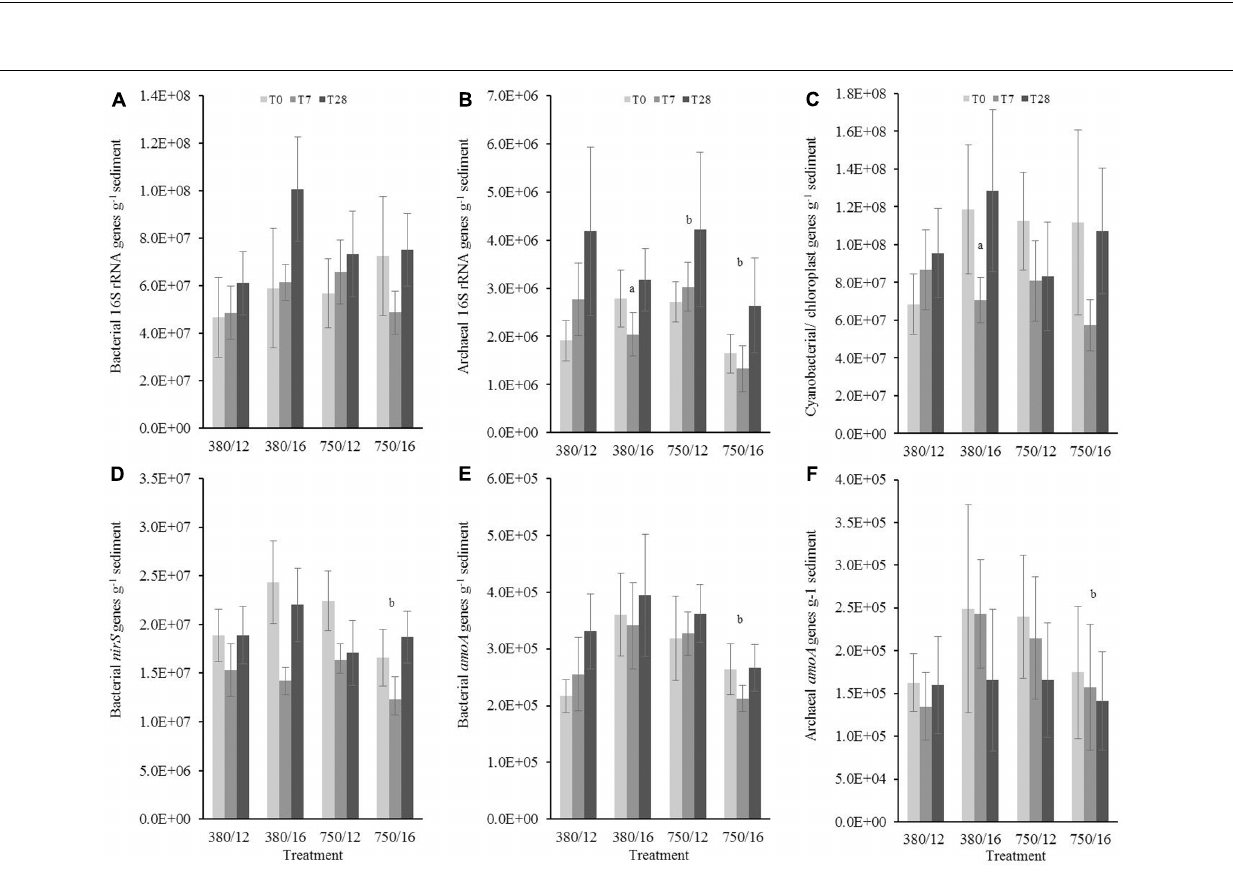
FIGURE 5 | The effects of CO 2 and/or temperature on the abundance (g − 1 sediment) of (A) bacterial 16S rRNA, (B) archaeal 16S rRNA, (C) cyanobacterial/chloroplast 16S rRNA, (D) bacterial nirS , (E) bacterial amoA genes, and (F) archaeal amoA genes in the top layer (0–1 cm) of sandy sediment. Four syringe cores were taken at each time point (T0, light gray; T7, dark gray; and T28, black) from each environmental treatment ( x -axis). Significant effects from the model output are indicated by the letter a (where there is an interaction with day); b (interaction between elevated CO 2 and elevated temperature). Error bars represent standard deviation of repeated measurements ( n = 4) from treatment replicates ( n =